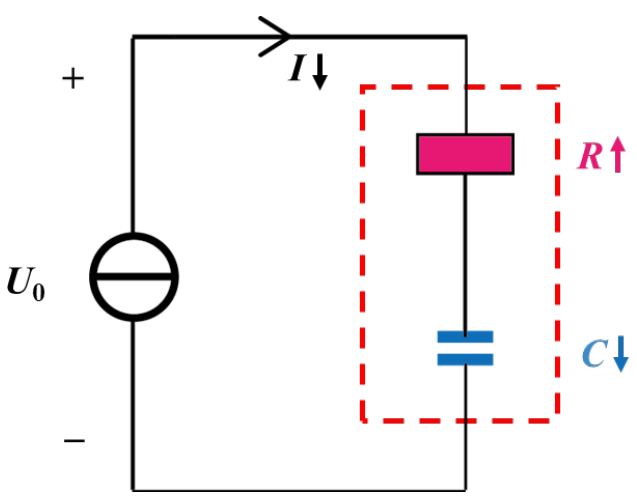
Figure 2. The circuit model of a